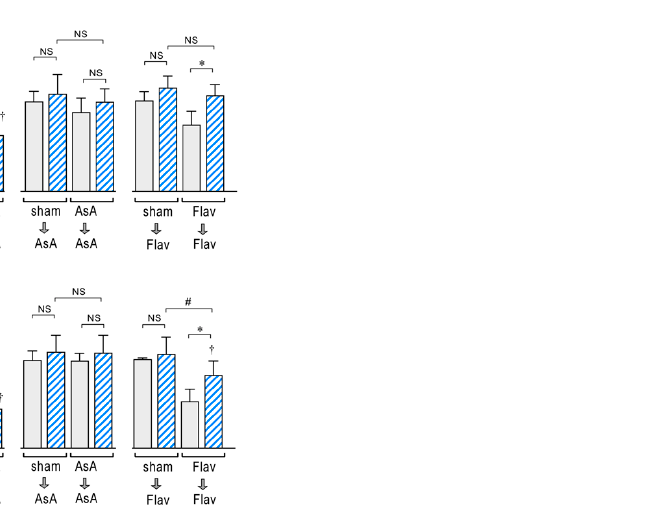
Figure 5. Vascular hyperpermeability through dietary supplementation based on ω -3 FA, ascorbic acid, or polyphenolic antioxidant flavonoids in survivor and non-survivor endotoxemic rats. After endotoxemia treatment supplemented with water (sham), ω -3 fatty acid ( ω -3 FA), ascorbic acid (AsA), or polyphenolic antioxidant flavonoids (Flav), through a therapeutic and a prophylactic protocol, the mesentery ( A ), kidney ( B ), and liver ( C ) were harvested and processed for EBD extraction to determine blood vessel hyperpermeability. EBD content was normalized to total sample weight. Statistical differences were assessed by two-way ANOVA followed by Dunnett’s post hoc test. * p < 0.05 comparing saline and endotoxemia condition. † p < 0.05, †† p < 0.01, ††† p < 0.001 compared with sham-treated condition. # p <0.05; ## p < 0.01 comparing non-survivor endotoxic condition between therapeutic and prophylactic protocol. NS: non-significant. Results are expressed as the mean ± SD ( N = 12).